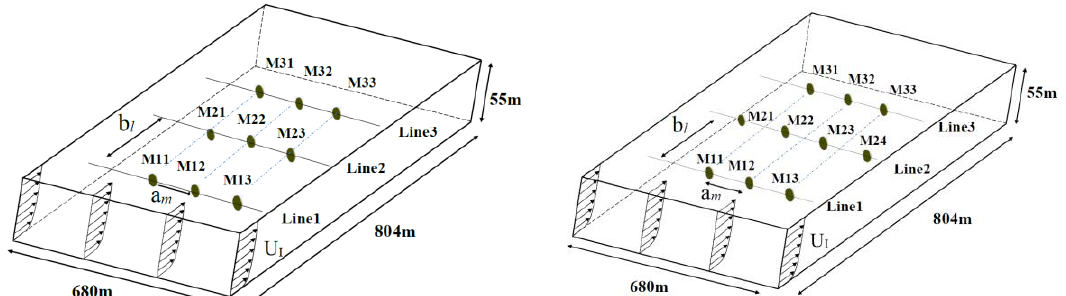
Figure 3. Calculation domains with the localization of the turbines: Aligned layout ( left ), staggered layout ( right ). b l = 7.5 D and a m = 3 D.